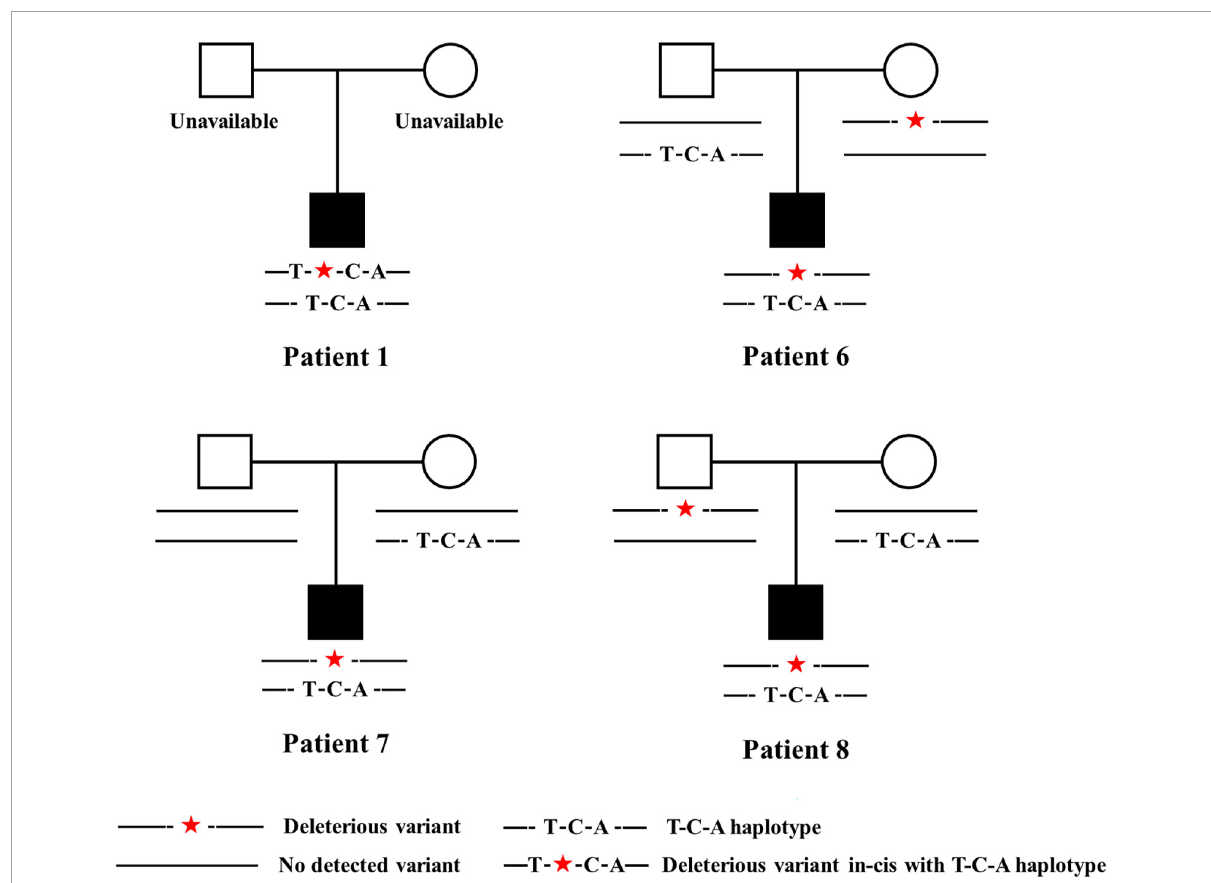
FIGURE3 Pedigrees of patients carrying TBX6 deleterious variants in-trans with T-C-A haplotypes. Patient 1 had c.745G > A/p.Val249Met, Patient 6 had c.271dupG/p.Val91fs × 79, Patient 7 had c.1115_1130dupAGGCTCCAGACTCCGG/p.Arg378fs × 66, and patient 8 had c.903T > G/p.Tyr301*. Legends are listed below. T-C-A, rs2289292 (C > T) – rs3809624 (T > C) – rs3809627 (C >